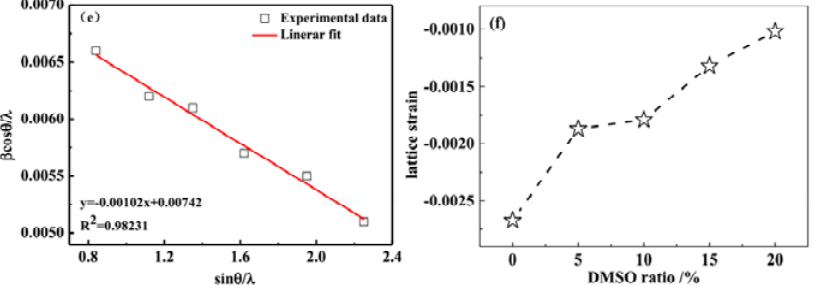
Figure 5. The lattice strain analysis plots for different ratios of DMSO added. ( a ) 0%; ( b ) 5%; ( c ) 10%; ( d ) 15%; ( e ) 20%. ( f ) The relationship between the lattice strains and DMSO ratios.